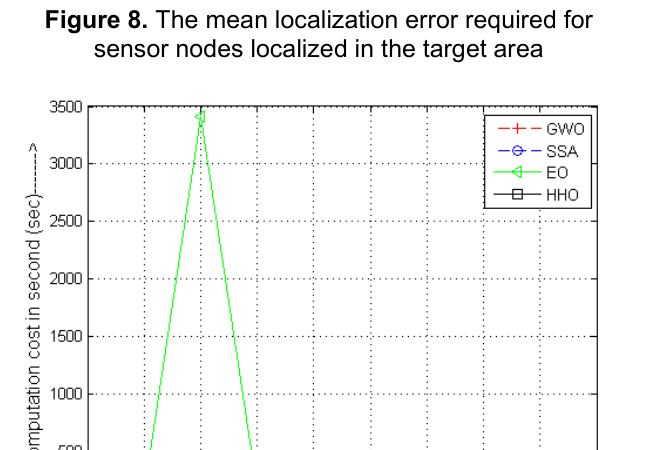
Figure 8. The mean localization error required for sensor nodes localized in the target area